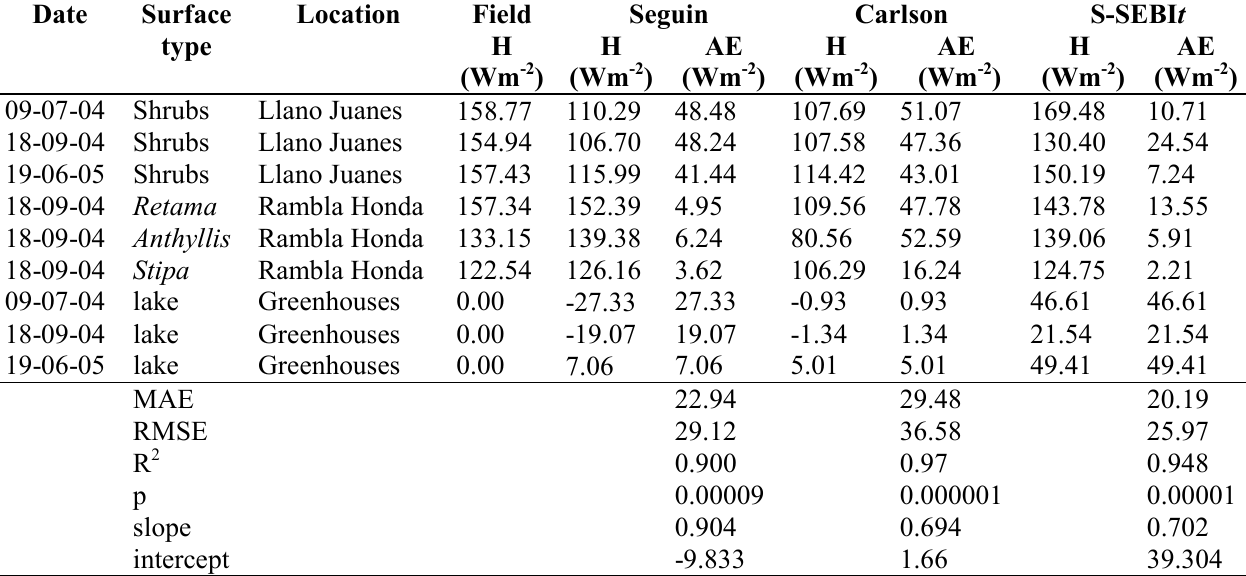
Table 4. Field validation of the daily sensible heat flux (H) in Wm -2 estimated by the H , H and H models. AE is the absolute error (absolute difference between model and Seguin Carlson S-SEBIt field observations). For overall error evaluation, the MAE (mean absolute error), which is the average AE, the R 2 (Pearson correlation coefficient), p (probability), slope and intercept of the regression between field and ASTER were calculated.